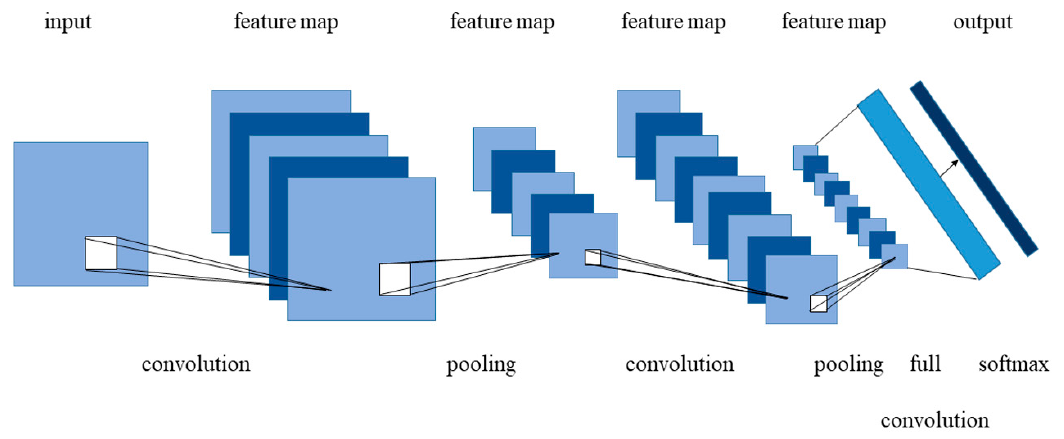
Figure 4. Overall architecture of Convolution Neural Networks. Table 1. Characteristics of various backbone networks in dense images.